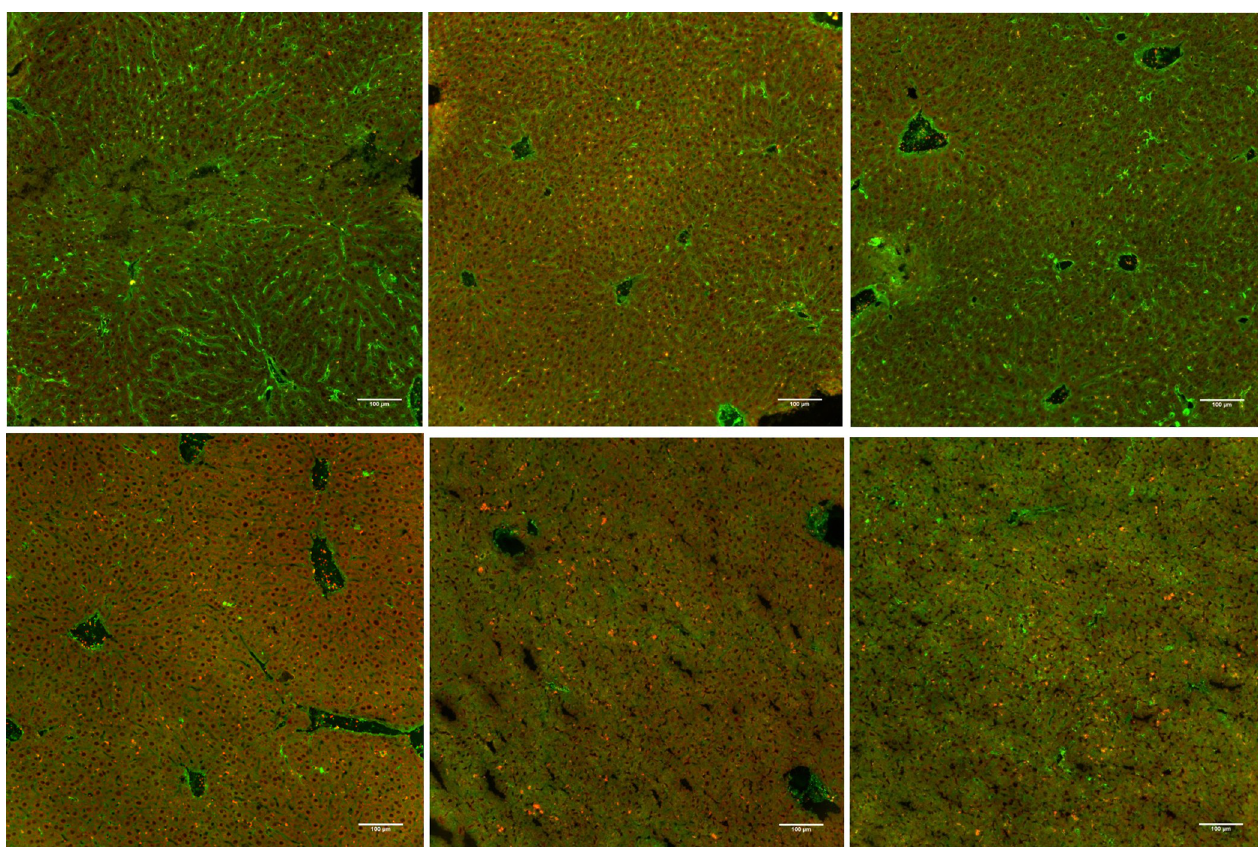
Fig 6. Frozen sections of the liver with immunohistochemistry staining with an anti-fibrinogen antibody Alexa 488 and platelet anti-CD 42c antibody TRITC. Pictured: left row untreated control animals (a-c) showing liver sections of untreated 8- to 10-week-old C57Bl/6 (3 examples a-c untreated and d-f CASP), the green dye (Alexa 488) represents the fibrinogen amount in the liver sinusoids, the orange dye (TRITC) shows platelet aggregates, the right column is 20 h after CASP surgery (d-f, scale bar 100 μ m, negative control not